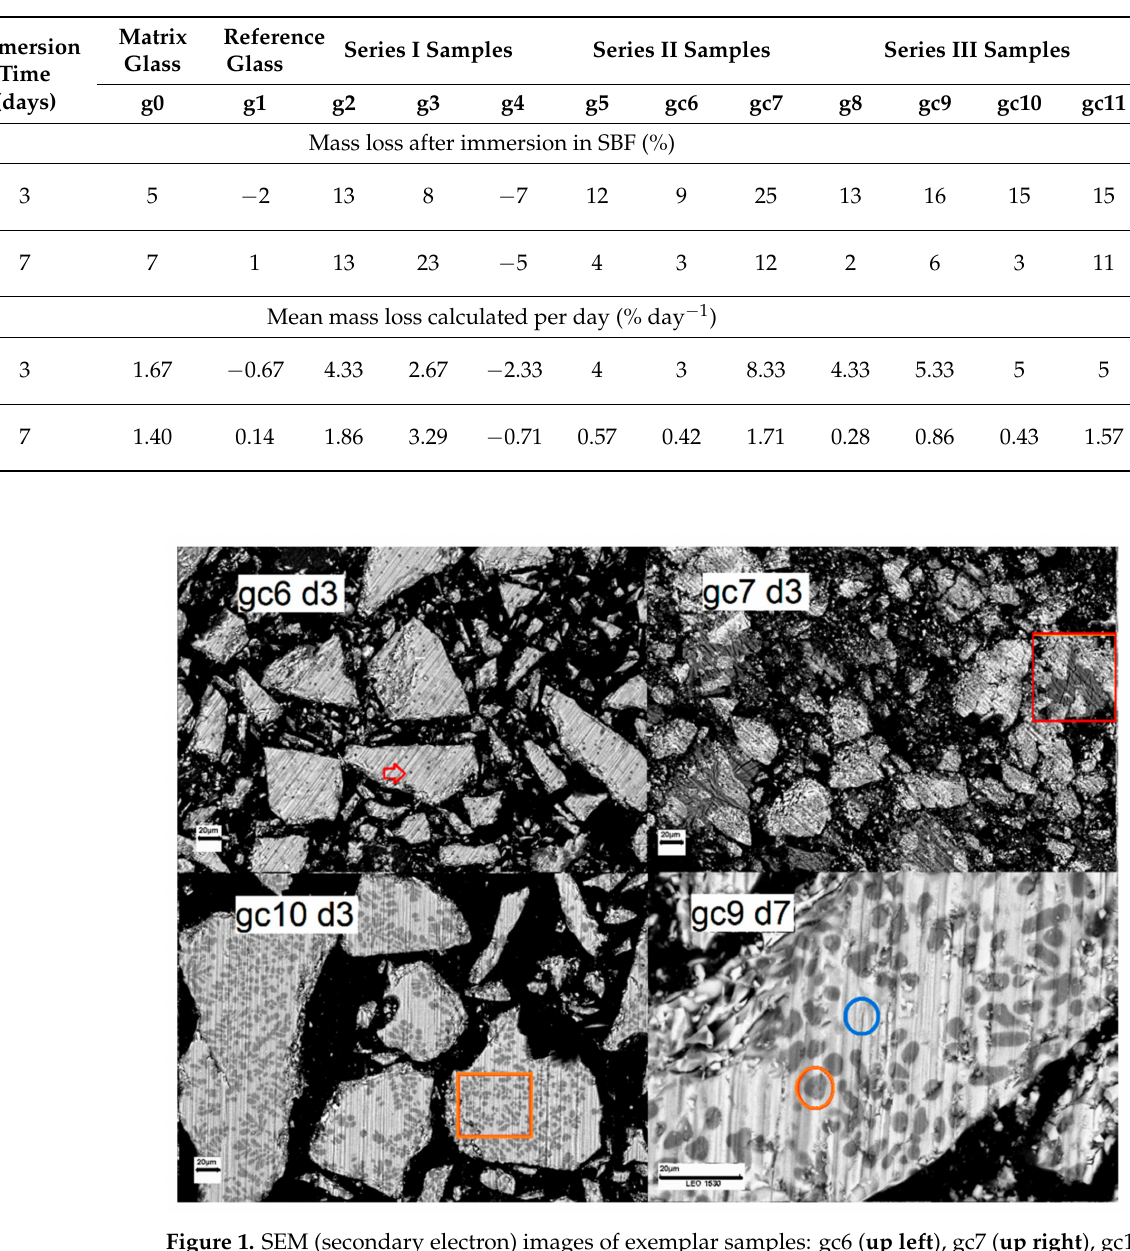
Table 2. Mass loss % and mean % mass loss calculated per day after initial stage of immersion (3 days) and long-term immersion (7 days) in SBF. Minus sign indicates an increase in mass.